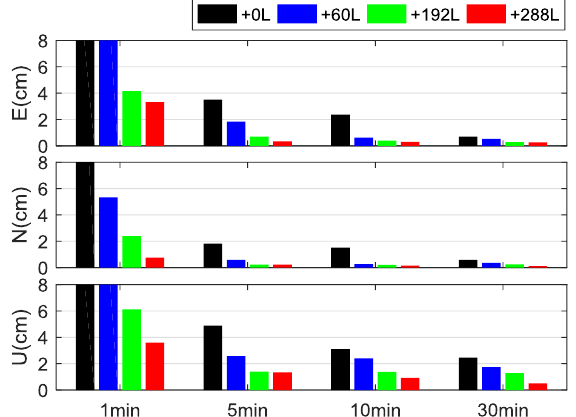
Figure 8. Positioning accuracy of static GREC PPP fixed solutions with different session lengths (1 min, 5 min, 10 min, and 30 min) with the augmentation of 0, 60, 192, and 288 LEO satellites.